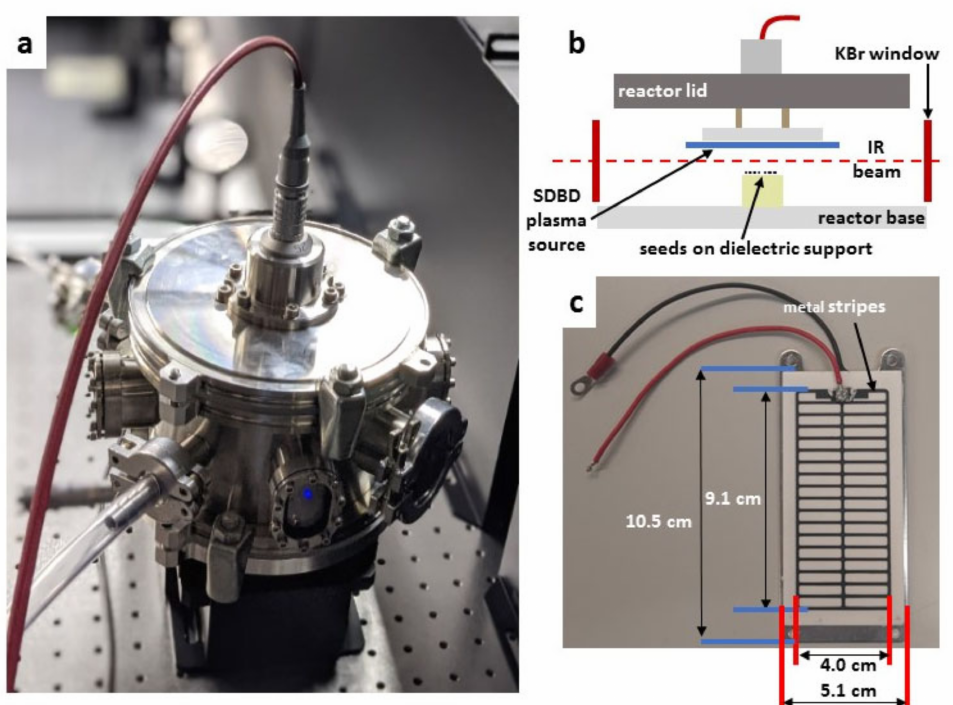
Figure 4. Surface dielectric barrier discharge (SDBD) plasma source enclosed in the plasma-seed treatment reactor. ( a ) Stainless steel reactor with high-voltage coaxial cable connection; ( b ) schematic of the interior with the inverted SDBD positioned above the seed substrate; ( c ) photograph of the high-voltage stripe SDBD electrode printed on an alumina dielectric plate. The ground electrode is an aluminum plate behind the